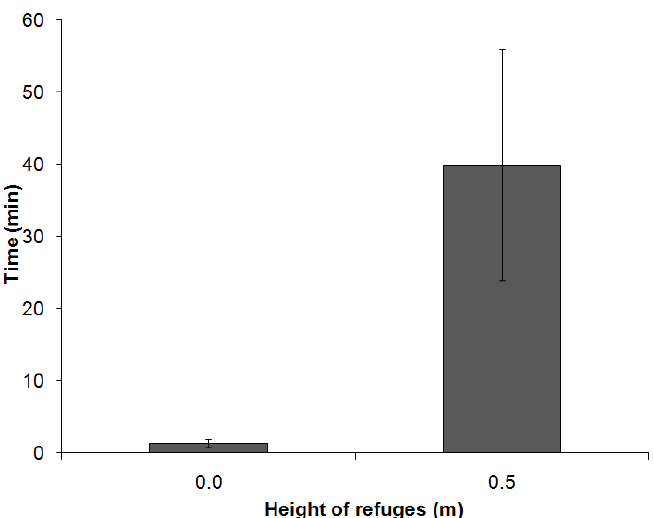
Figure 6. Lengths of stay of the animals within the refuges at heights of 0.0 m ( n = 20) and 0.5 m ( n = 7) ( * p = 0.004, Mann-Whitney).